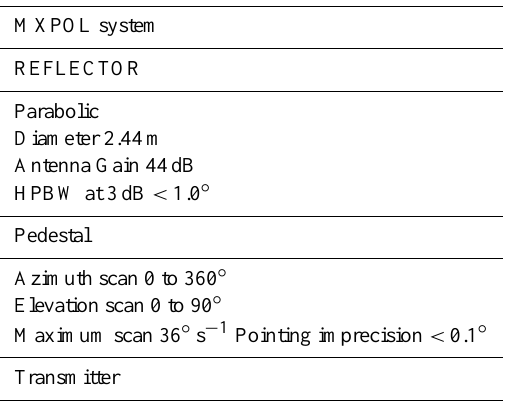
Table 1. Main parameters of the